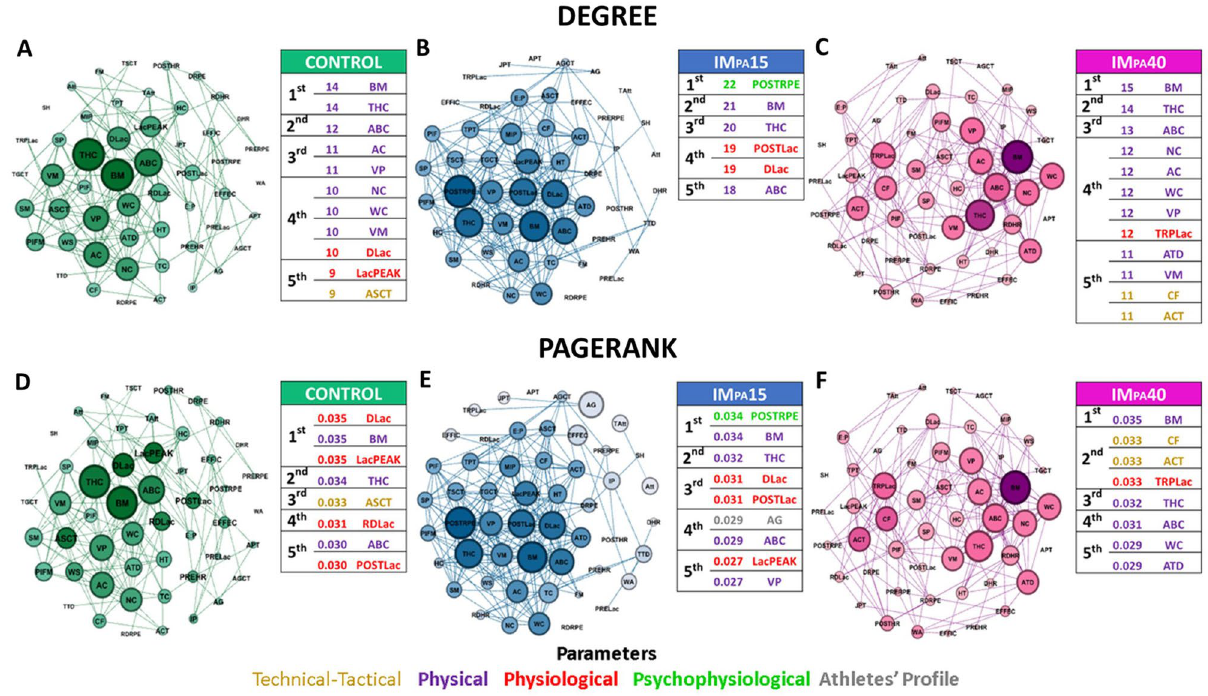
Figure 4. Three scenarios of a simulated judo match represented by graphs, considering the Degree and Pagerank centrality measurements: ( A , D ) Control; ( B , E ) IM PA 15 e ( C , F ) IM PA 40). The tables demonstrate top- five node results involving athletes’ profile (grey), technical-tactical (yellow), physical (purple), physiological (red), and psychophysiological (green). AG: Age; JPT: Judo Practice Time; HT: Height; WS: Wingspan; BM: Body Mass; TTD: Transverse Thoracic Diameter; ATD: Anteroposterior Thoracic Diameter; NC: Neck Circumference; AC: Arm Circumference Flexed; TC: Thorax Circumference; WC: Waist Circumference; ABC: Abdominal Circumference; HC: Hip Circumference; THC: Thigh Circumference; FM: Fat Mass; MIP: Maximal Inspiratory Pressure; SM: S-index Mean; SP: S-index Peak; PIFM: Peak Inspiratory Flow (mean); PIF: Peak Inspiratory Flow (peak); VM: Volume (mean); VP: Volume (peak); PRELac: Pre-Combat Blood Lactate; POSTLac: Post-Combat Blood Lactate; DLac: Delta of Blood Lactate; LacPEAK: Peak of Blood Lactate; TRPLac: Time to Reach the Peak of Blood Lactate; RDLac: Rate of Decay of Blood Lactate; PREHR: Pre-Combat Heart Rate; POSTHR: Post-Combat Heart Rate; DHR: Delta of Heart Rate; RDHR: Rate of Decay of Heart Rate; PRERPE: Pre-Combat—Rating of Perceived Exertion; POSTRPE: Post-Combat—Rating of Perceived Exertion; DRPE: Delta of Rating of Perceived Exertion; RDRPE: Rate of Decay of Rating of Perceived Exertion; CF: Combat Frequency; ACT: Average Combat Time; TPT: Total Pause Time; APT: Average Pause Time; TSCT: Total Standing Combat Time; TGCT: Total Groundwork Combat Time; ASCT: Average Standing Combat Time; AGCT: Average Groundwork Combat Time; TAtt: Time between Attacks; E:P: Effort-pause ratio; Att: Attacks; EFFEC: Effectiveness; EFFIC: Efficiency; IP: Ippon ; WA: Wazari ; SH: